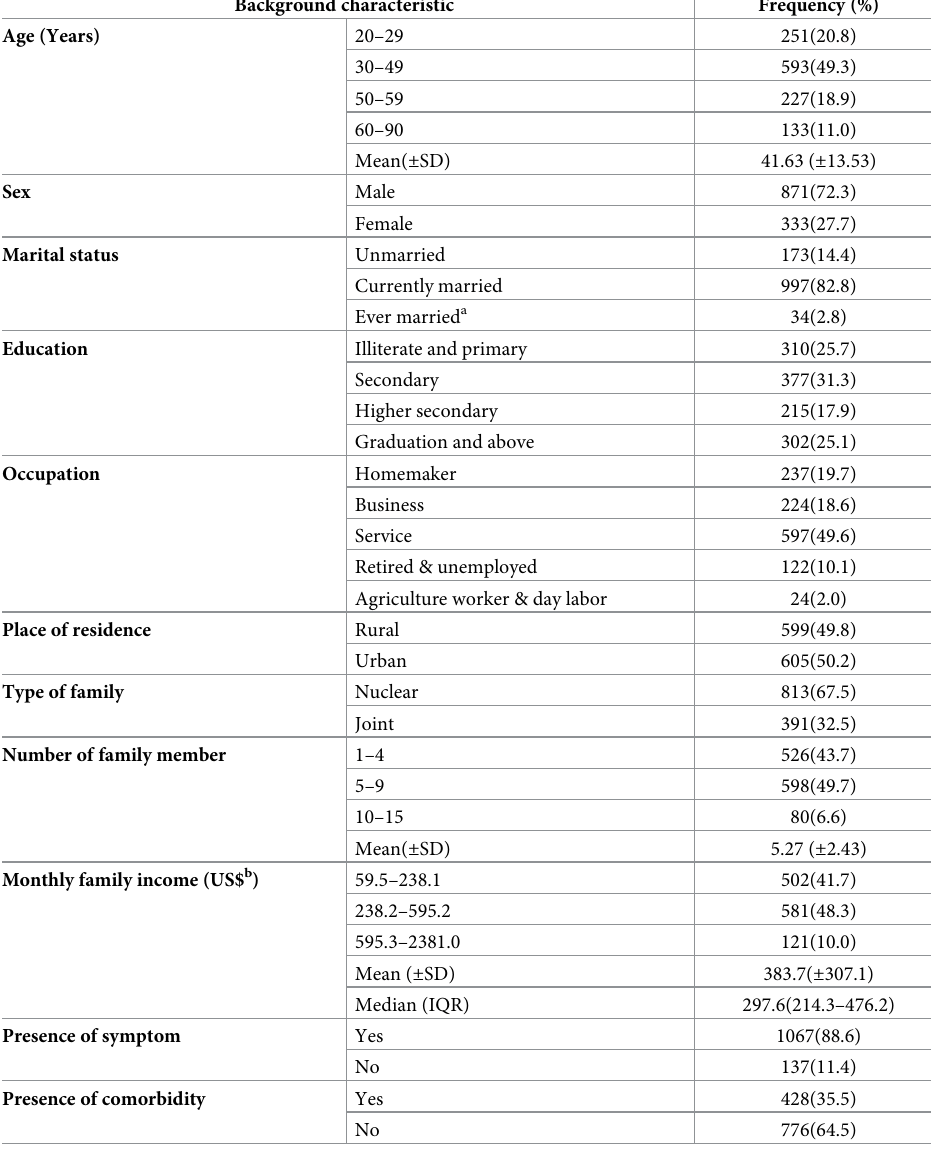
Table 1. Distribution of the COVID-19 patients by background characteristics (n =